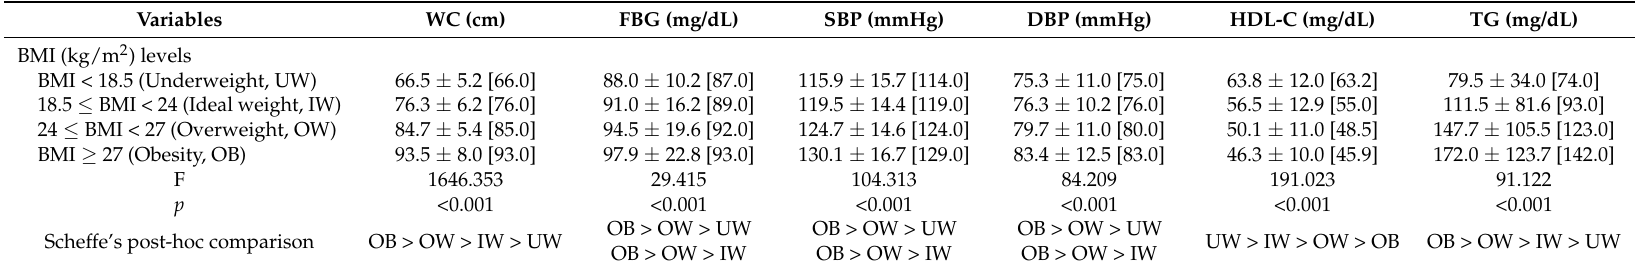
Table 2. Relationships between the BMI levels and metabolic risk factors † .